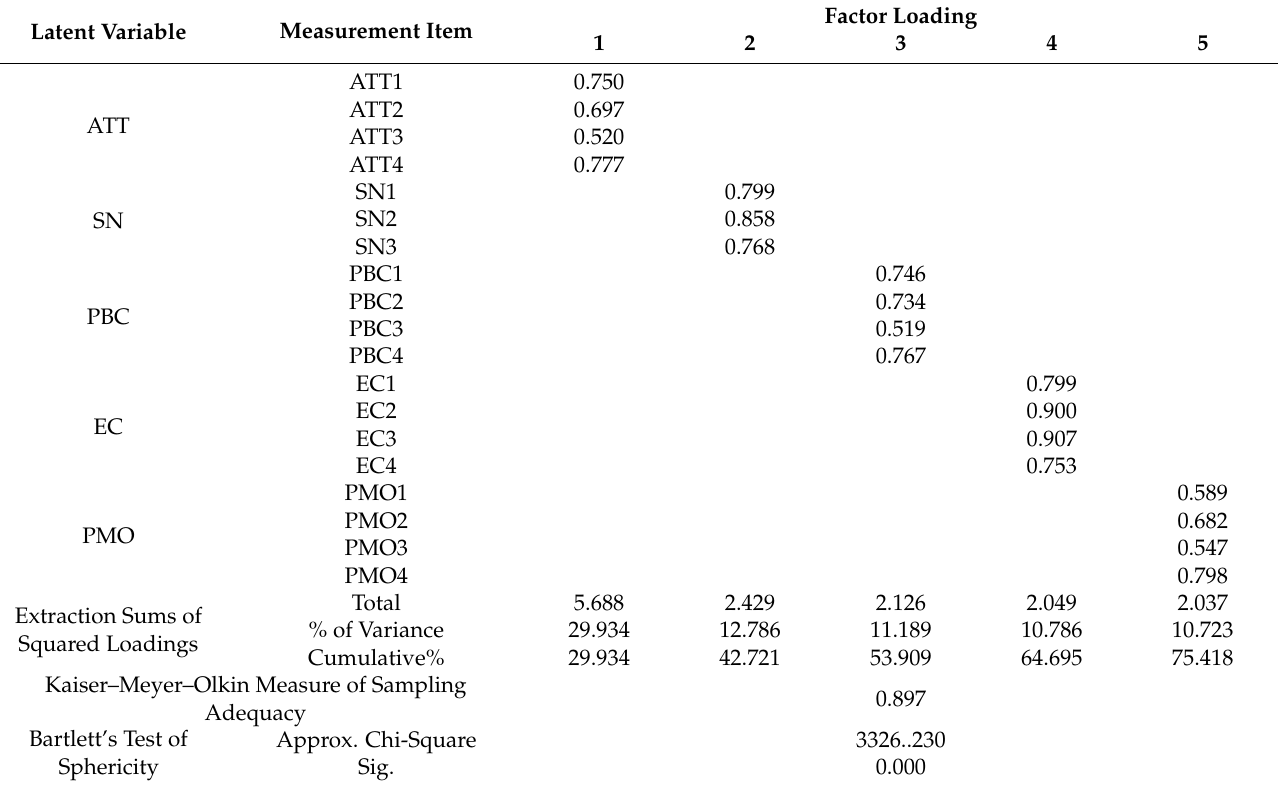
Table 6. Structural validity test results of ATT, SN, PBC, EC and